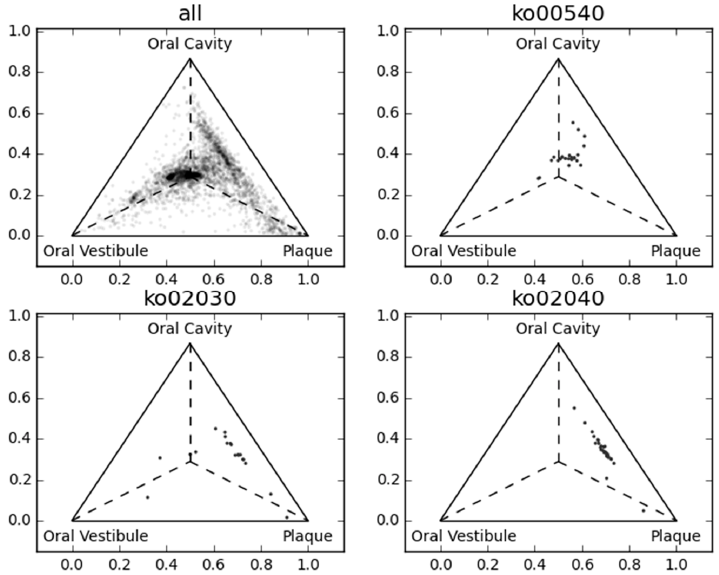
Figure 5. Comparison of the average relative abundance among three oral site groups. Orthologous groups are represented as dots in each ternary plot based on their average relative abundance. The centroid of the triangle represents an equal average relative abundance of the three oral site groups.